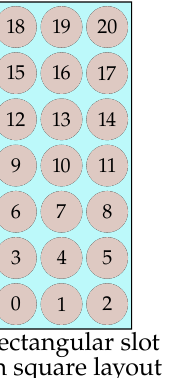
Figure 2. Example of different possibilities of shapes and